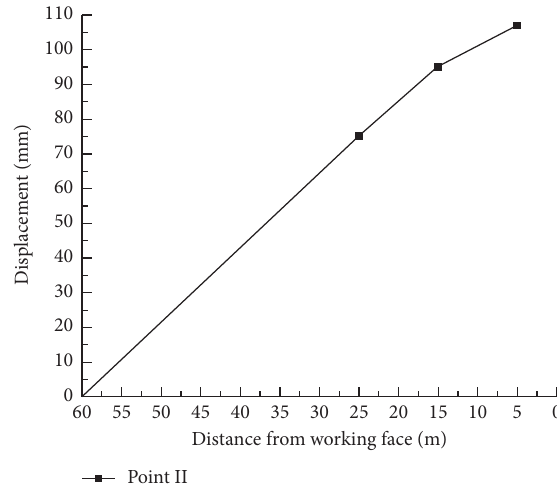
Figure 6: Displacements of roof and floor at Point II of auxiliary haulage channel.